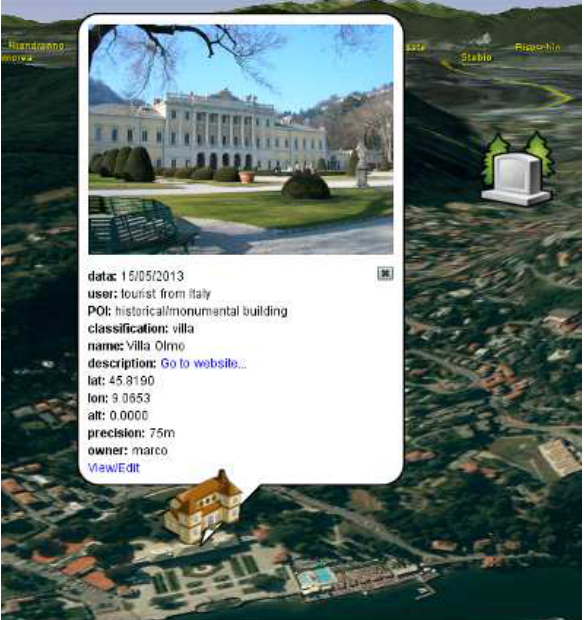
Figure 4. Example of POIs 3D visualization at small altitudes with a balloon showing field-collected information